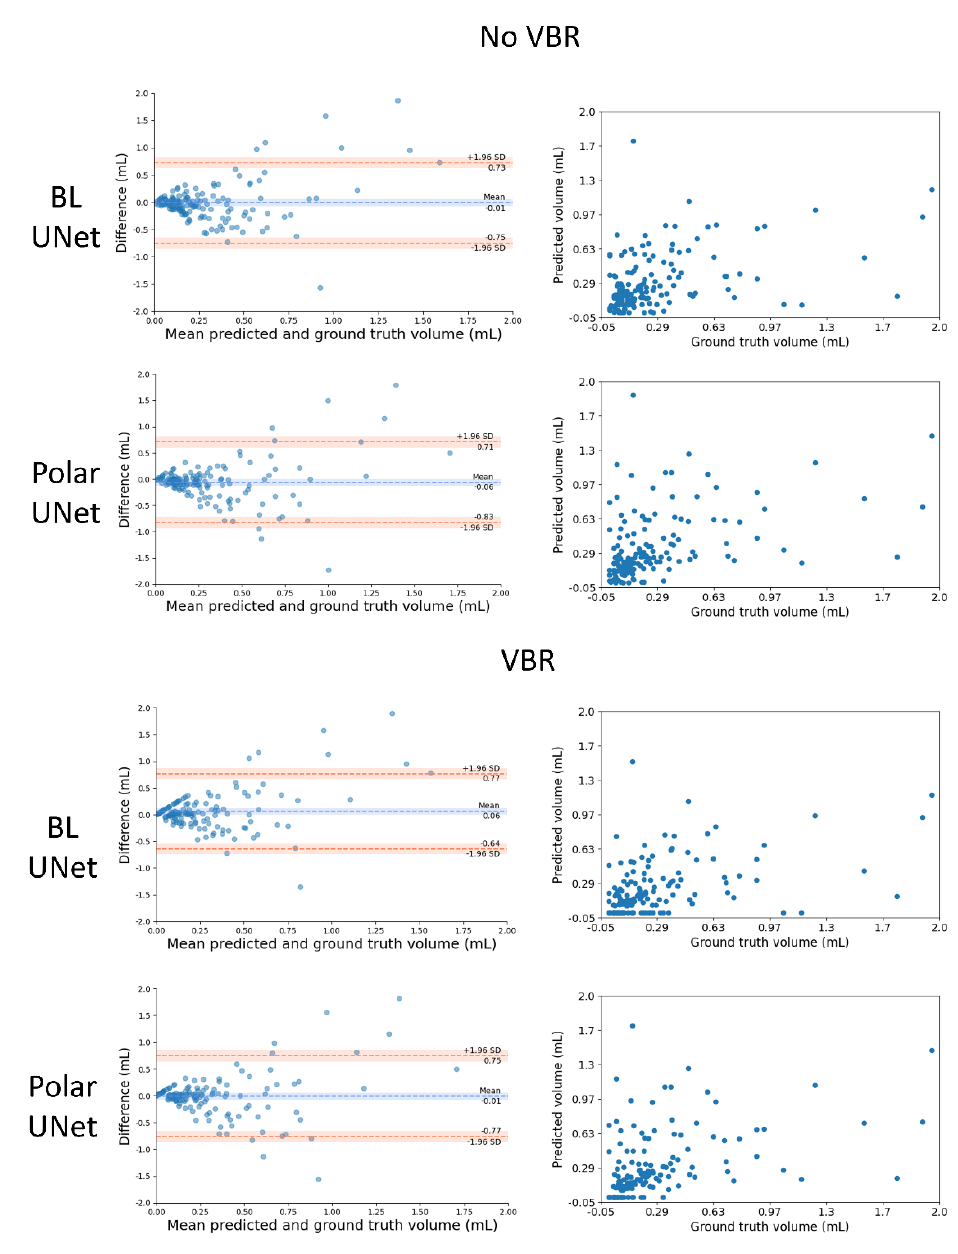
Figure 3. Comparison of the automated and manually segmented volume for the BL-UNet and Polar-UNet with and without volume-based removal (VBR). Left column: Bland–Altman plots of the lesion volumes. The volumes corresponding to the reference and automatic segmentations are shown on the x-axis, and the volume difference is shown on the y-axis. Right column: scatter plots comparing lesion volumes derived from the reference segmentations (y-axis) and from the automatic segmentations determined by the CNN (x-axis).